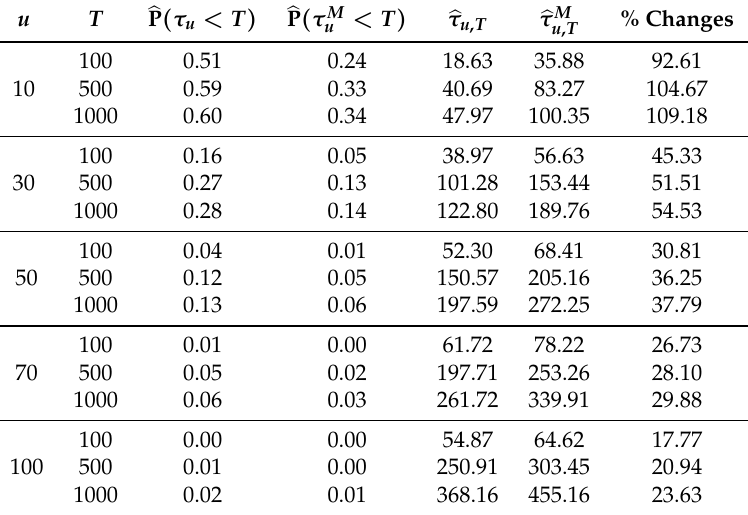
Table 3. LCR reinsurance for IG ( 2,1.5 ) distributed claims. The safety loading is θ = 0.1, expected claim size is µ = 2, claim arrival rate is λ = 1, and each time unit is 0.01 years. Simulations are done with N = 100,000 sample